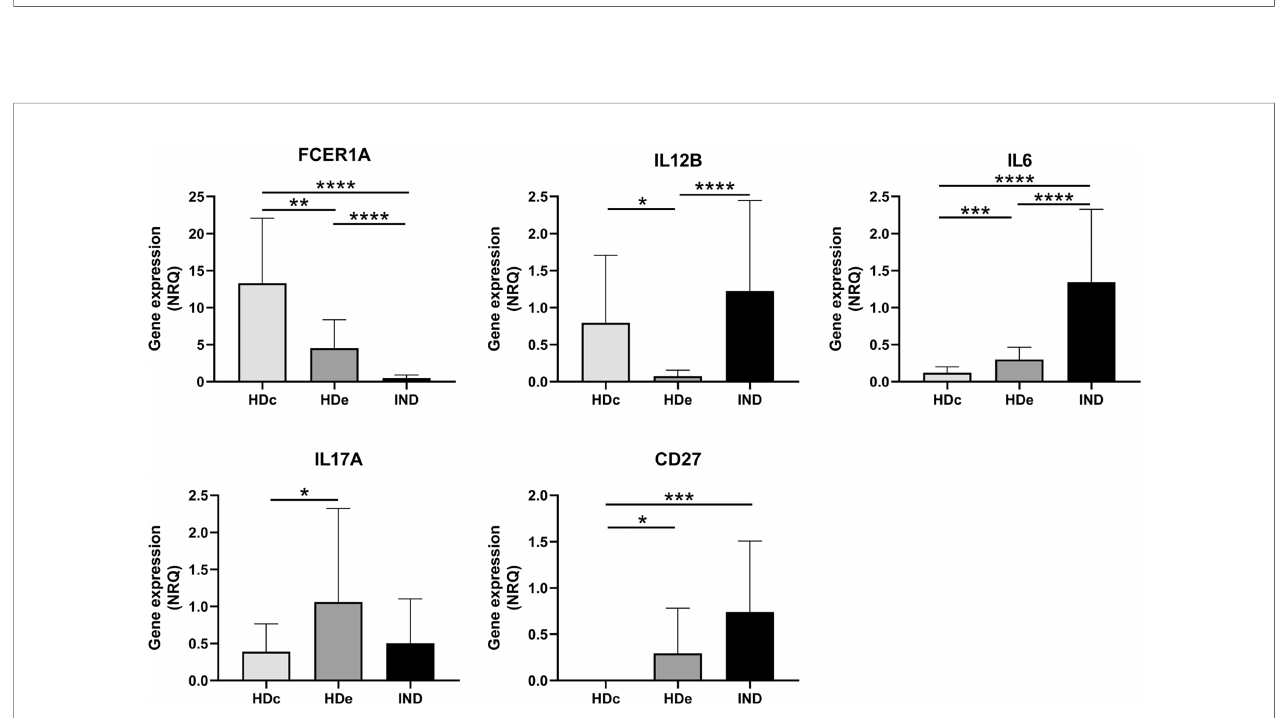
FIGURE 5 | Comparative analysis of the expression levels of FCER1A , IL12B , IL6 , IL17A , and CD27 genes measured as mean normalized relative quantities (NRQ) in patients with chronic Chagas disease with indeterminate form of the disease (IND) and healthy donors from endemic (HDe) and non-endemic (HDc) areas of Chagas disease. Statistically signi fi cant differences determined by the two-tailed Mann – Whitney test or two-tailed unpaired t-test, as appropriate, are indicated (* p < 0.05, ** p < 0.01, *** p < 0.001, and **** p <